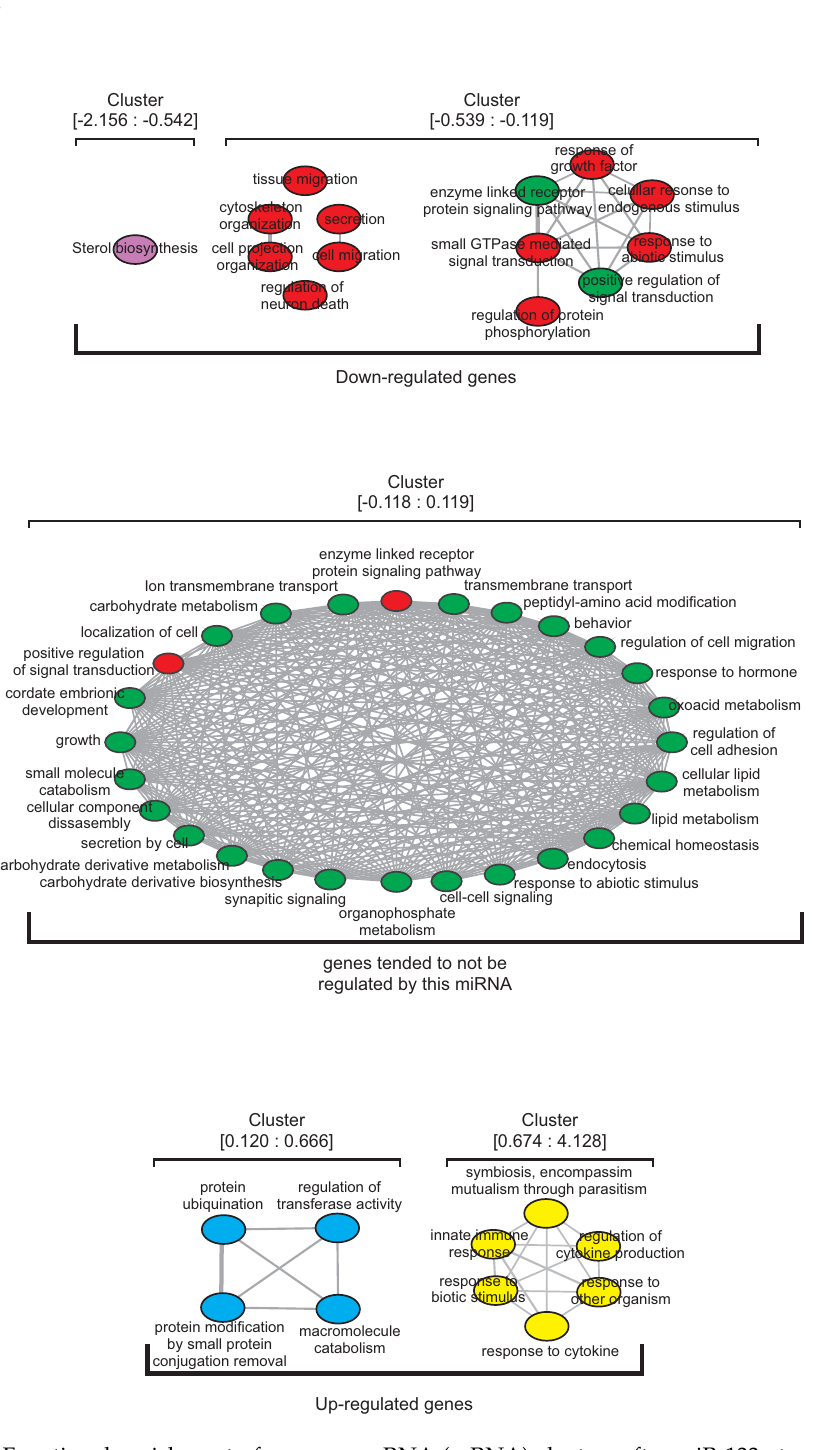
Figure 2. Functional enrichment of messenger RNA (mRNA) clusters after miR-133a transfection. Purple terms belongs to the cluster ( − 2.156: − 0.542), red terms to the cluster ( − 0.539: − 0.119), green terms to the cluster ( − 0.118:0.119), blue terms to the cluster (0.120:0.666) and yellow terms to the cluster (0.674:4.128). The numbers within brackets represent the minimum and maximum fold change values of each cluster. Terms with different colors inside a cluster indicate that the same term is also present in the cluster of that color. Grey edges connect highly similar terms, and the edge width indicates the similarity degree. Results for other miRNAs can be visualized at Supplementary Figure S4 and a detailed description of the terms found in each cluster can be visualized at Supplementary Table